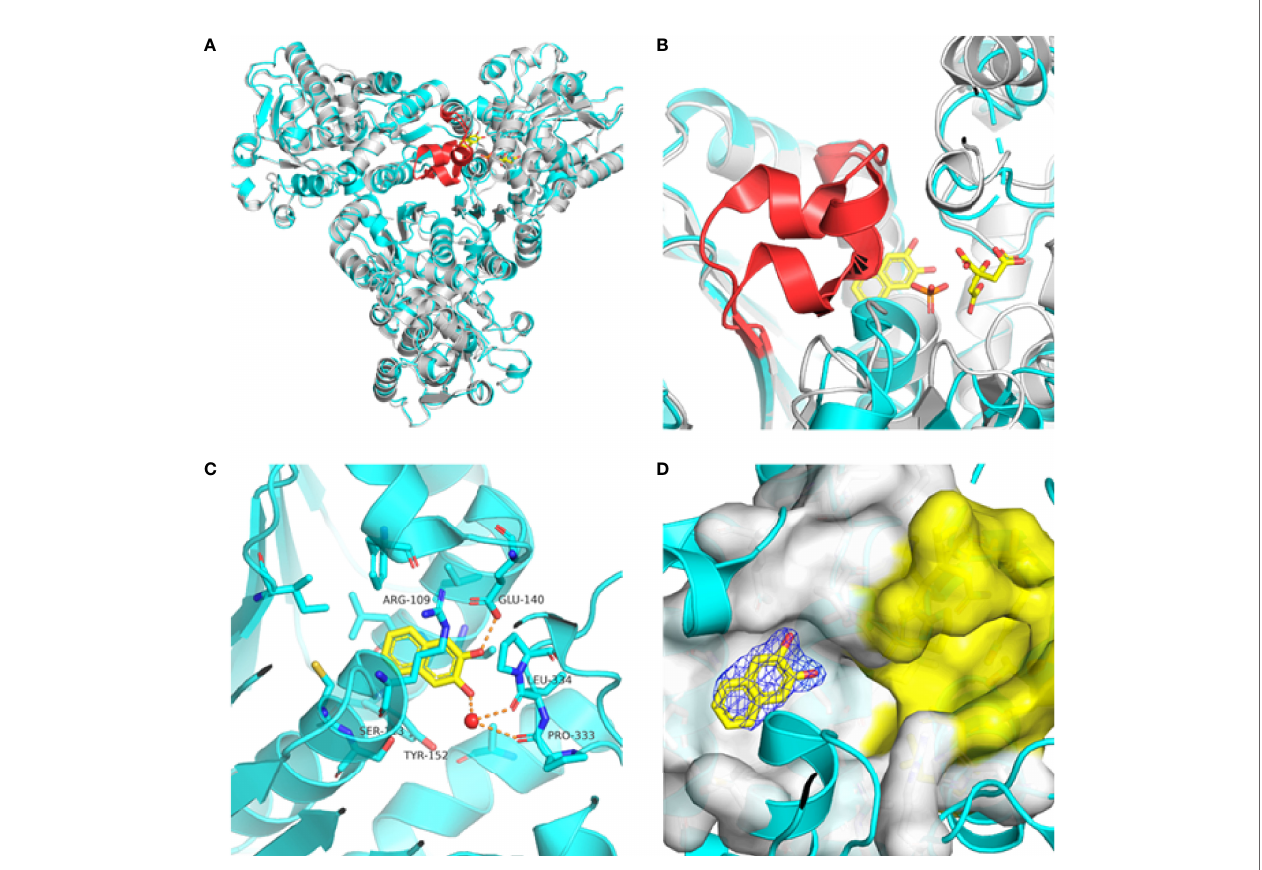
FIGURE 4 | Crystal structure of the 2,3-naphthalenediol- Pf ATCase complex. (A) structural alignment of the 2,3-naphthalenediol-bounded Pf ATCase [PDB ID: 6FBA; blue (Lunev et al., 2018)] with citrate-bound Pf ATCase [PDB ID: 5ILN; grey (Lunev et al., 2018)], RMSD=0.478 Å, providing a structural model of Pf ATCase in the T- state compared with the R-state. The location of the active site is shown for orientation. The conformational change in the loop128-142 in both cases is highlighted in red. (B) shows the structural rearrangements of 2,3-naphthalenediol binding site, the traditional active site is highlighted in yellow for orientation, 2Fo-Fc electron density of 2,3-naphthalenediol is shown in blue mesh at a contour of 1.0 s . (C) shows the binding site of 2,3-naphthalenediol and the polar contacts between 2,3- naphthalenediol and surrounding residues. (D) magni fi ed view of the newly discovered allosteric binding site and active binding site. The structural alignments were carried out with Pymol (Schrödinger and DeLano,